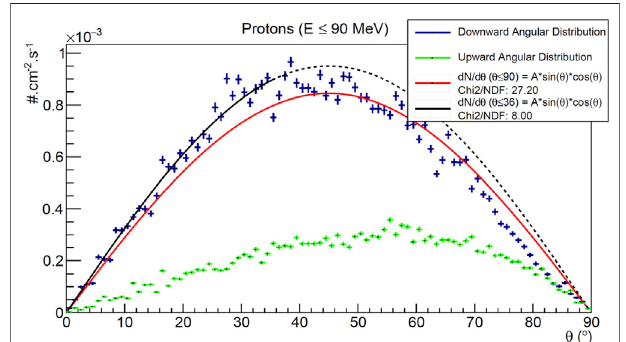
FIGURE 4 | Zenith angle distribution of protons with E < 90 MeV reaching the Mars surface, coming from primary spectra of GCR-protons and 4 He. The zenith angle of both upward (green data points) and downward going protons (blue data points) is measured with respect to the corresponding normal vectors to the surface. The black and the red lines represent the fi ts to isotropy for the downward going protons within the fi eld- of-view of the RAD, and for all zenith angles, respectively.